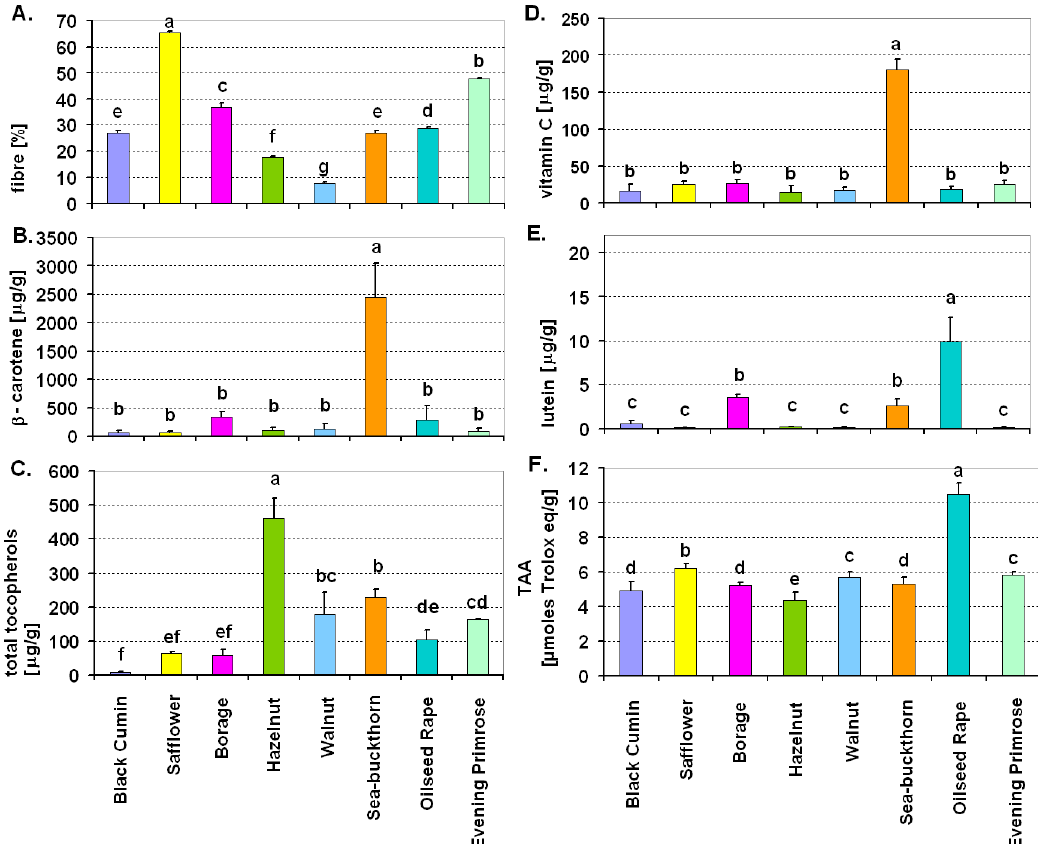
Figure 3. Contents of fibre ( A ), β -carotene ( B ), total tocopherols ( C ), vitamin C ( D ), lutein ( E ) and total low molecular weight antioxidant activity (TAA) ( F ) in oil cakes of eight species after cold-press of oil. Values marked with the same letters are not significantly different according to the Duncan test ( p ≤ 0.05).